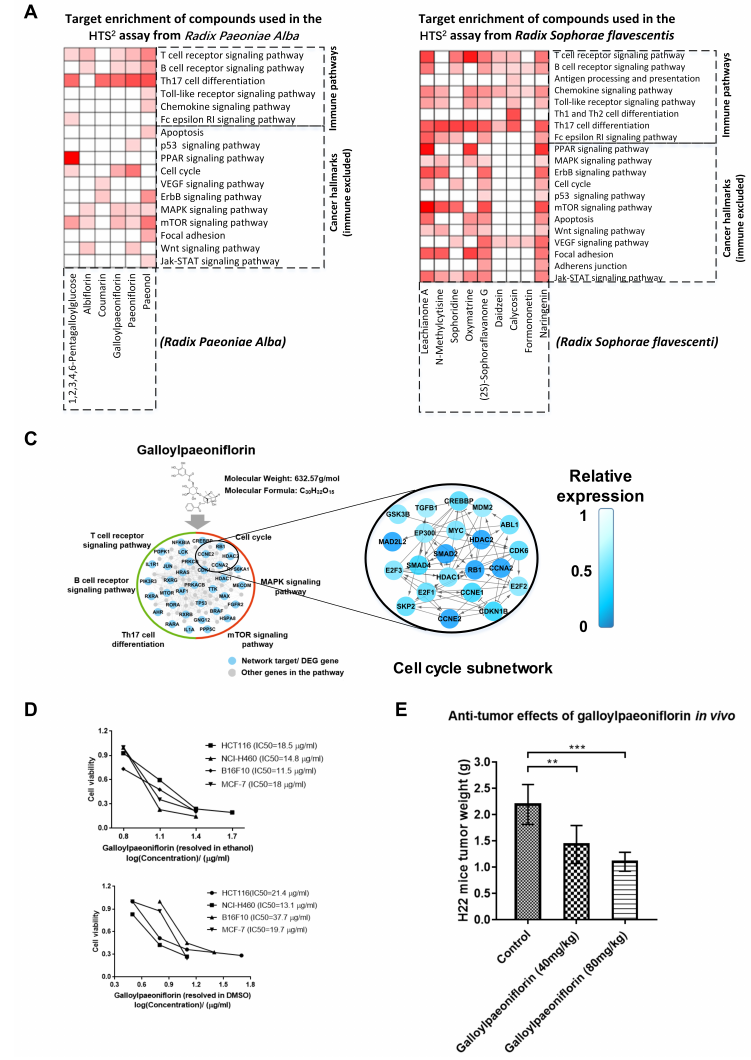
Figure 5. Identification of the immune regulatory and other antitumor biological functions of compounds from Radix Paeoniae Alba ( Bai Shao ) and Radix Sophorae flavescentis ( Ku Shen ). ( A , B ) The comprehensive functional characterization of the compounds in Radix Paeoniae Alba (A) or Radix Sophorae flavescentis (B) using the pathway enrichment analysis based on target prediction results. The white blanks represent pathways not regulated by the compounds according to HTS 2 assay results. ( C ) The pathway regulation effects of galloylpaeoniflorin, a compound in Radix Paeoniae Alba ( Bai Shao ) using the target enrichment and HTS 2 assay. A subnetwork representing the expression of the predicted targets of galloylpaeoniflorin in the cell cycle pathway was shown. ( D ) Inhibitory effects of galloylpaeoniflorin on tumor cell proliferation using the cell lines of several tumor types, as assessed using an MTT assay. The experiment was done once in triplicate. ( E ) Inhibitory effects of galloylpaeoniflorin on tumor growth in H22 mice. The assay was performed on seven BALB/c/nu nude female mice injected with the H22 tumor for each group. ** p < 0.01, *** p < 0.001, compared with the solvent control group. Statistical analysis was performed using multiple t tests. Data represent mean ±